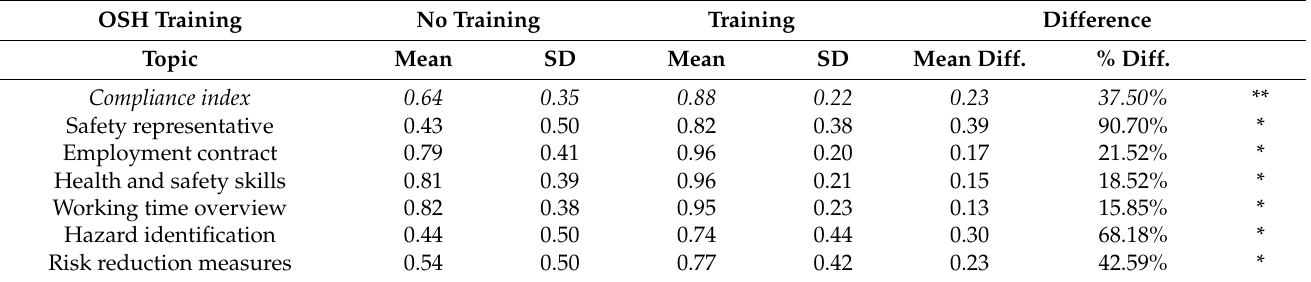
Table 3. Scores on checkpoints and index (no training vs. training), including t -test of mean